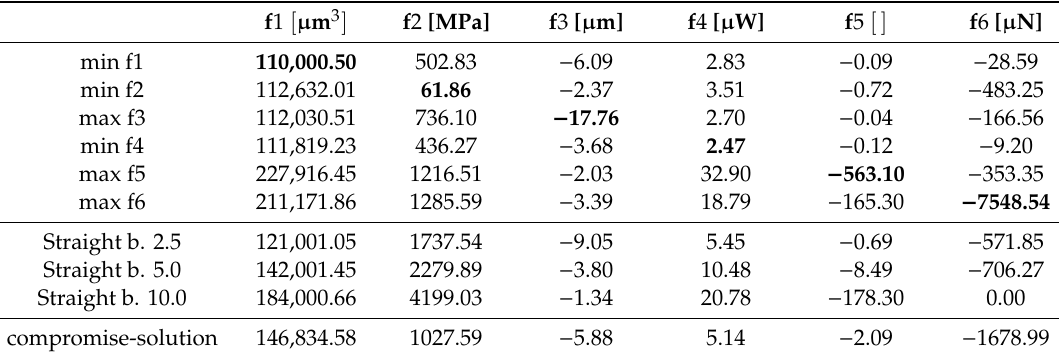
Table 2. Results of the optimization—values of the objective